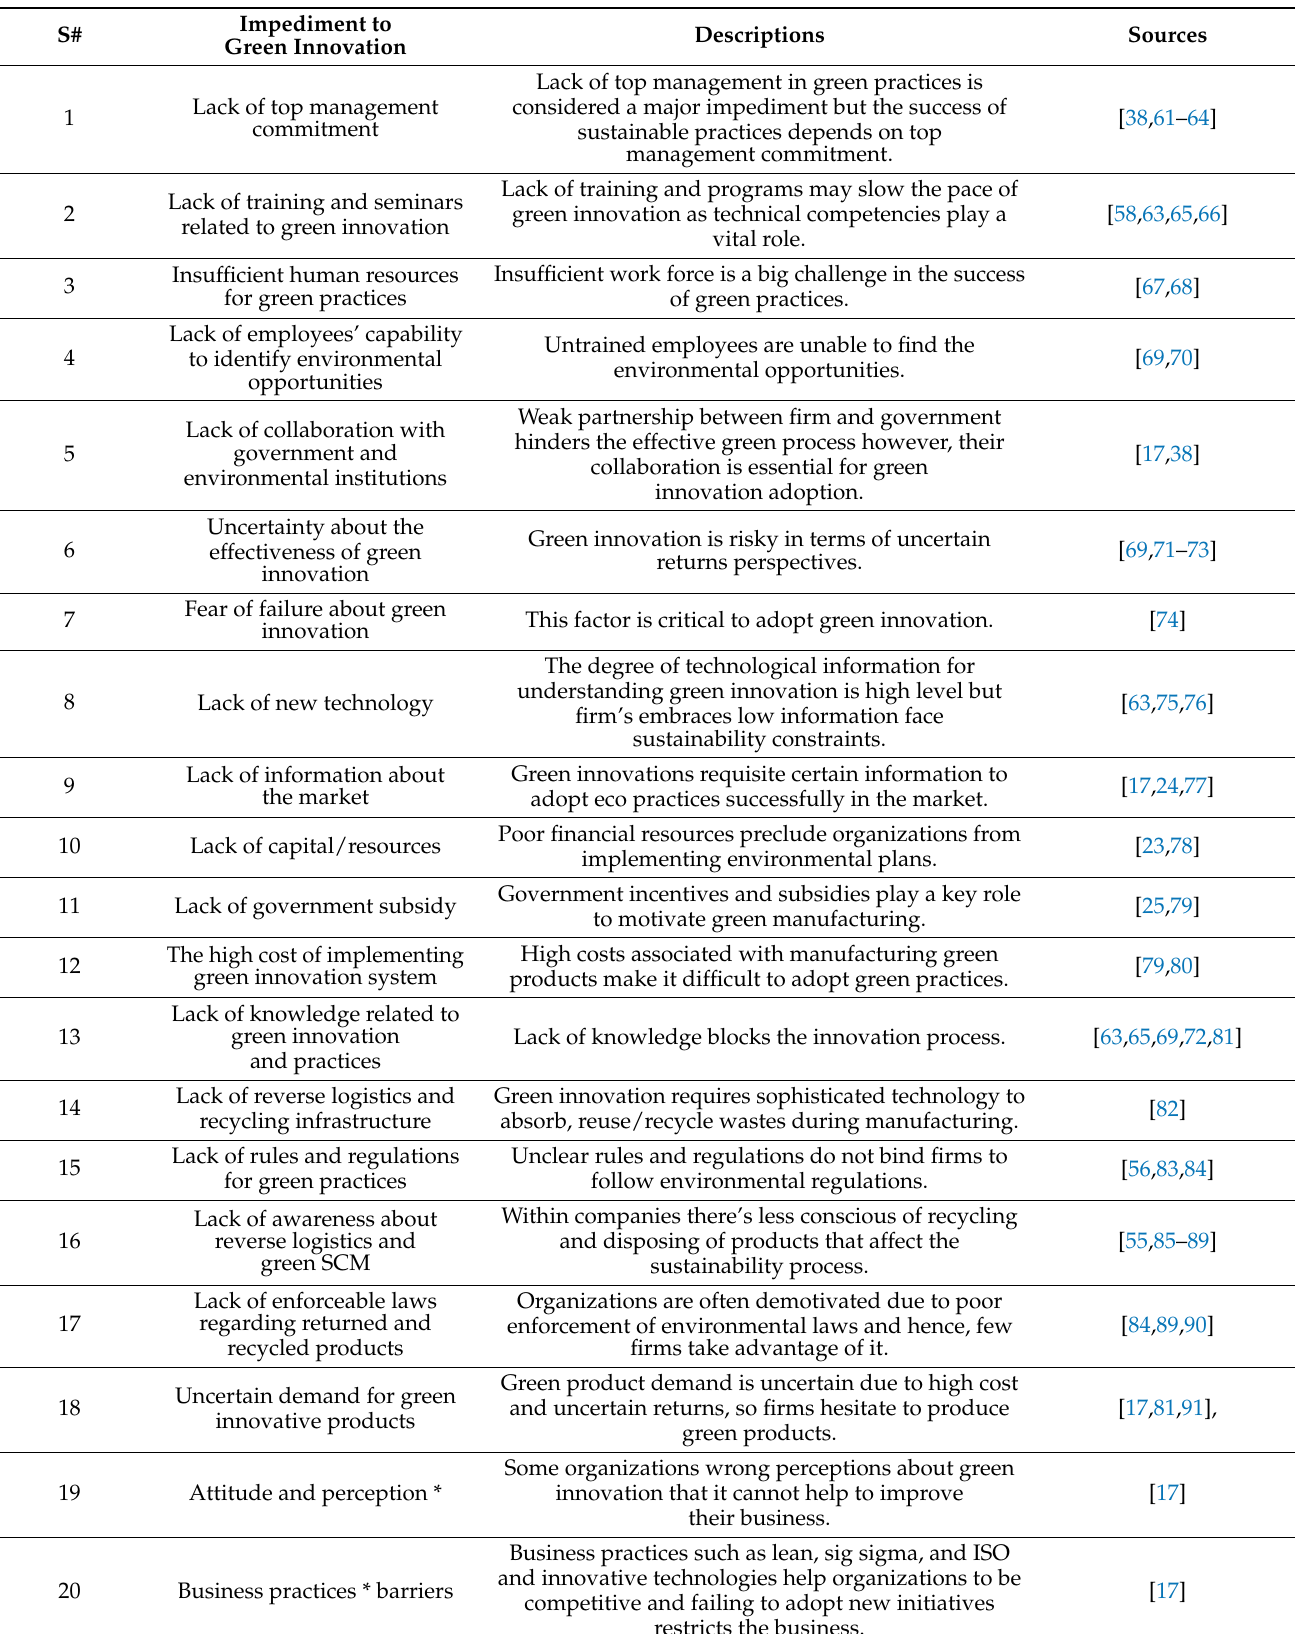
Table 1. Summary of key barriers of green innovation